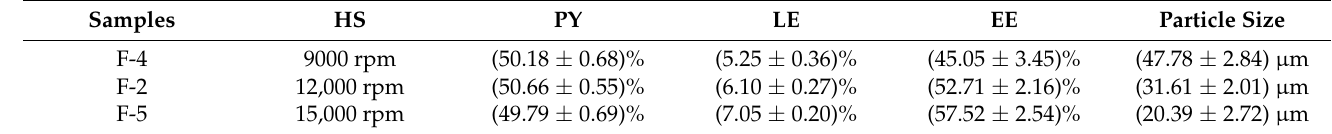
Table 4. The influence of homogenization speed ( n = 3, mean ± SD).